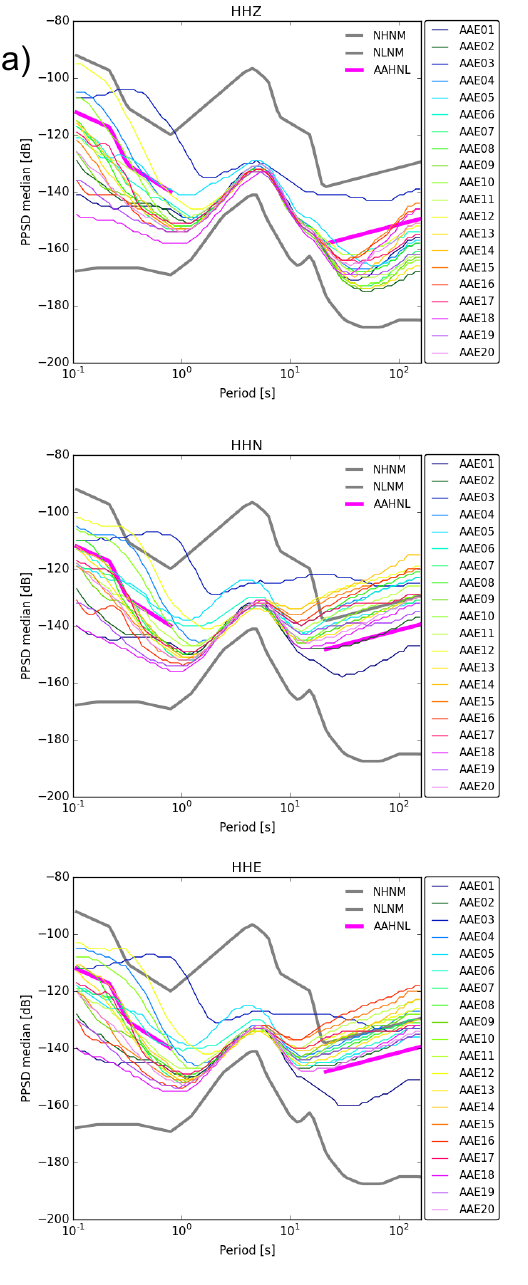
Figure 8. Medians of the probabilistic power spectral density (PPSD) of seismic noise at the MOBNET stations involved (a) in the AlpArray- EASI complementary experiment and (b) in the AlpArray Seismic Network (AASN). The grey thick lines mark the New Low and New High Noise models (NLNM and NHNM; Peterson, 1993). The thick red line (AlpArray high noise limit, AAHNL) marks the upper limit of the recommended noise level below the